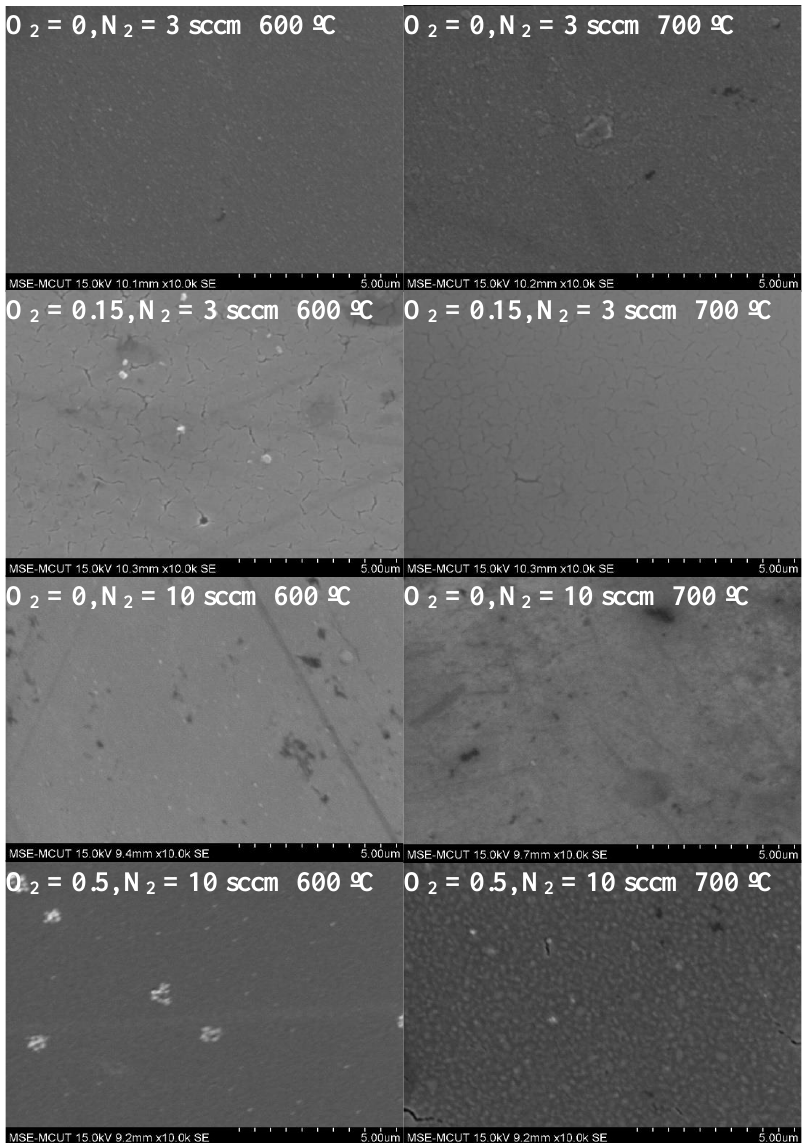
Figure 5. SEM of films annealed at 600 °C and 700 °C for different oxygen/nitrogen flow rates.